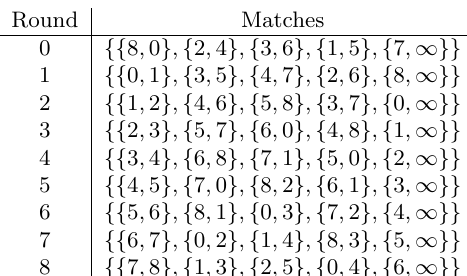
A round-robin tournament of order 10 constructed from the starter , . 3 , 6 1 , 5 { } { }}